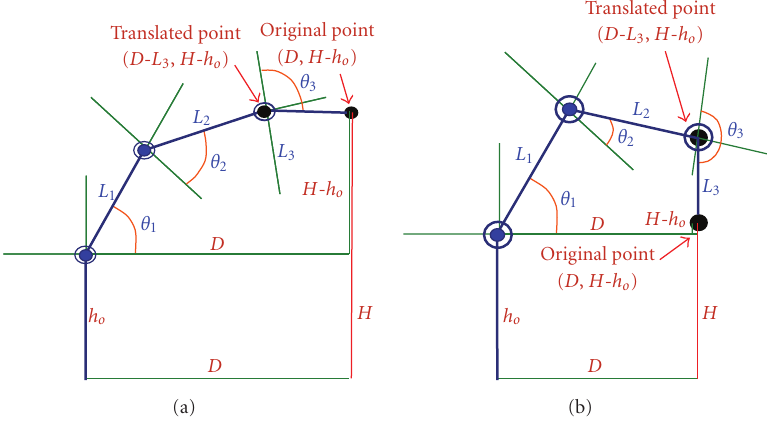
Figure 6: The link L 3 is parallel to ground (a) and perpendicular to ground (b).